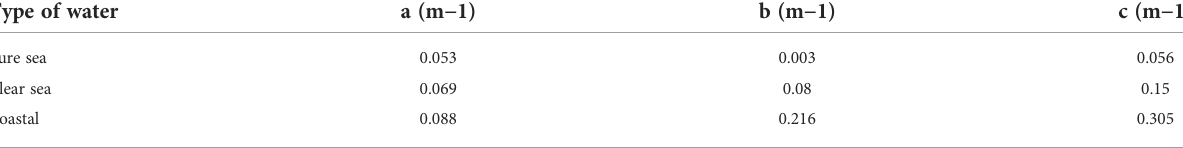
TABLE 1 Characteristic parameters of different types of